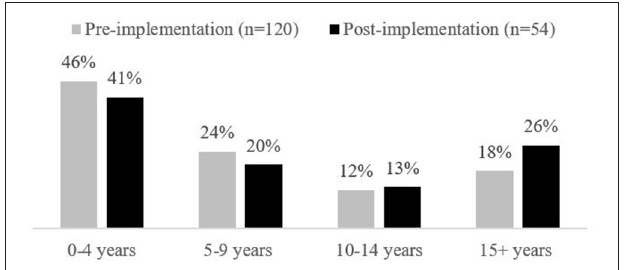
FIGURE 2 | Staff years of experience in pediatric intensive care setting.